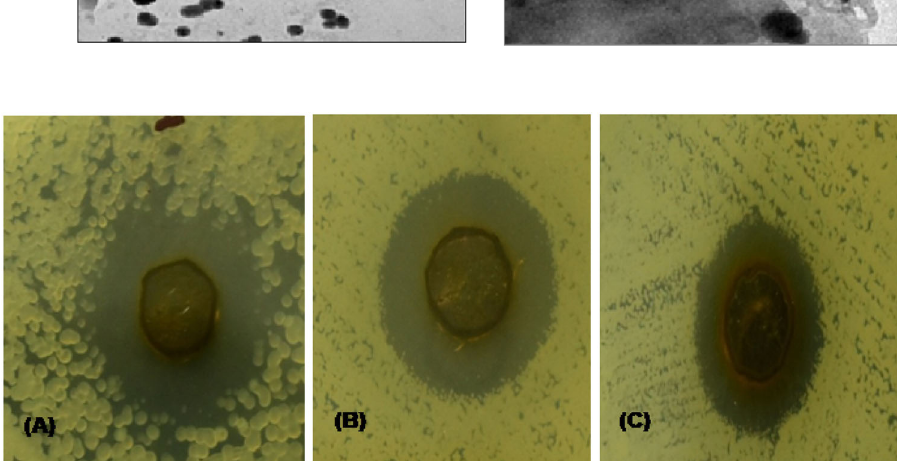
Fig. 5 Antibacterial activity in agar well diffusion method (A) E. coli (B) S. aureus